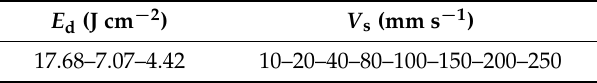
Table 1. Laser processing